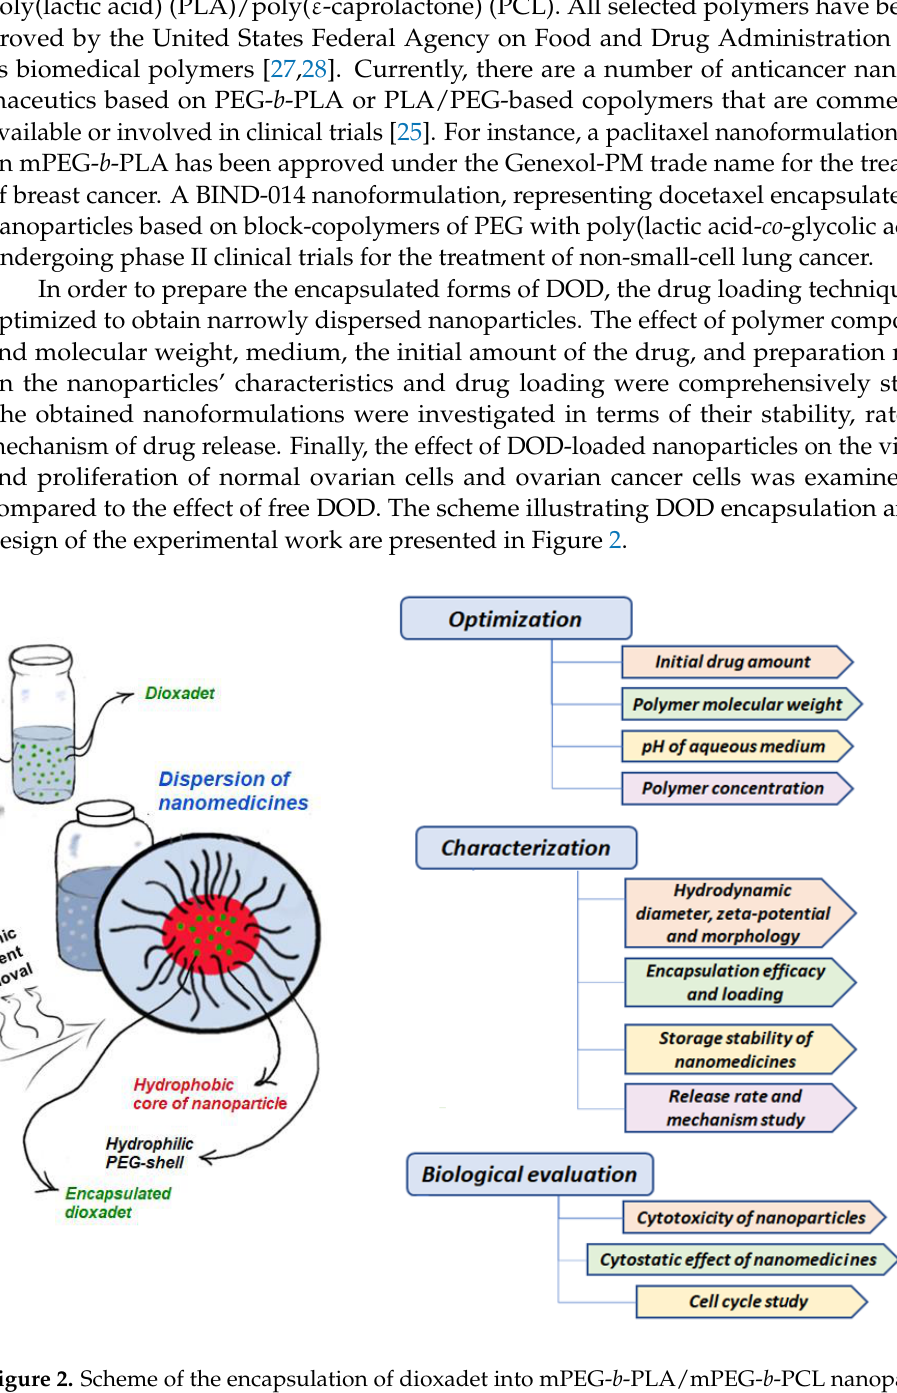
Figure 2. Scheme of the encapsulation of dioxadet into mPEG- b -PLA/mPEG- b -PCL nanoparticles and the design of the study.